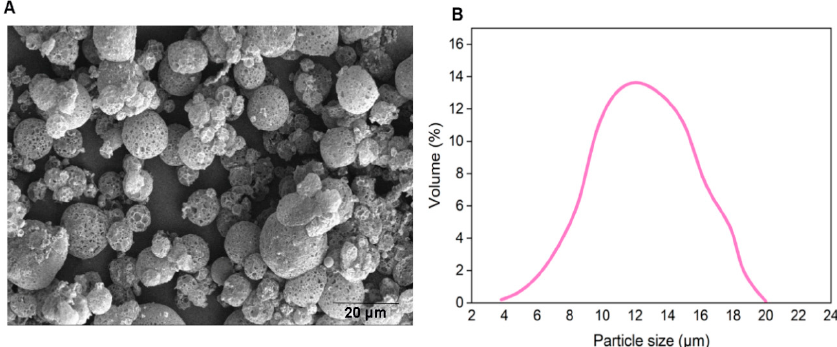
Figure 4. A. SEM of empty MPs. B. Size distribution of porous empty MPs